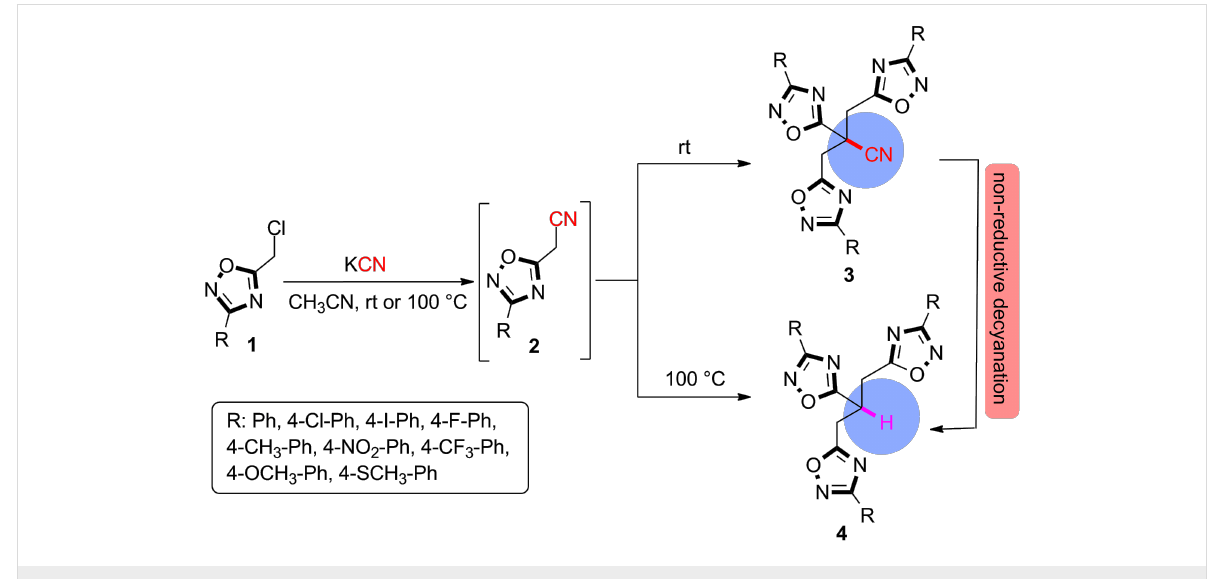
Figure 2: Cyanation through 5-chloromethyl-3-( p -substituted-phenyl)-1,2,4-oxadiazole.